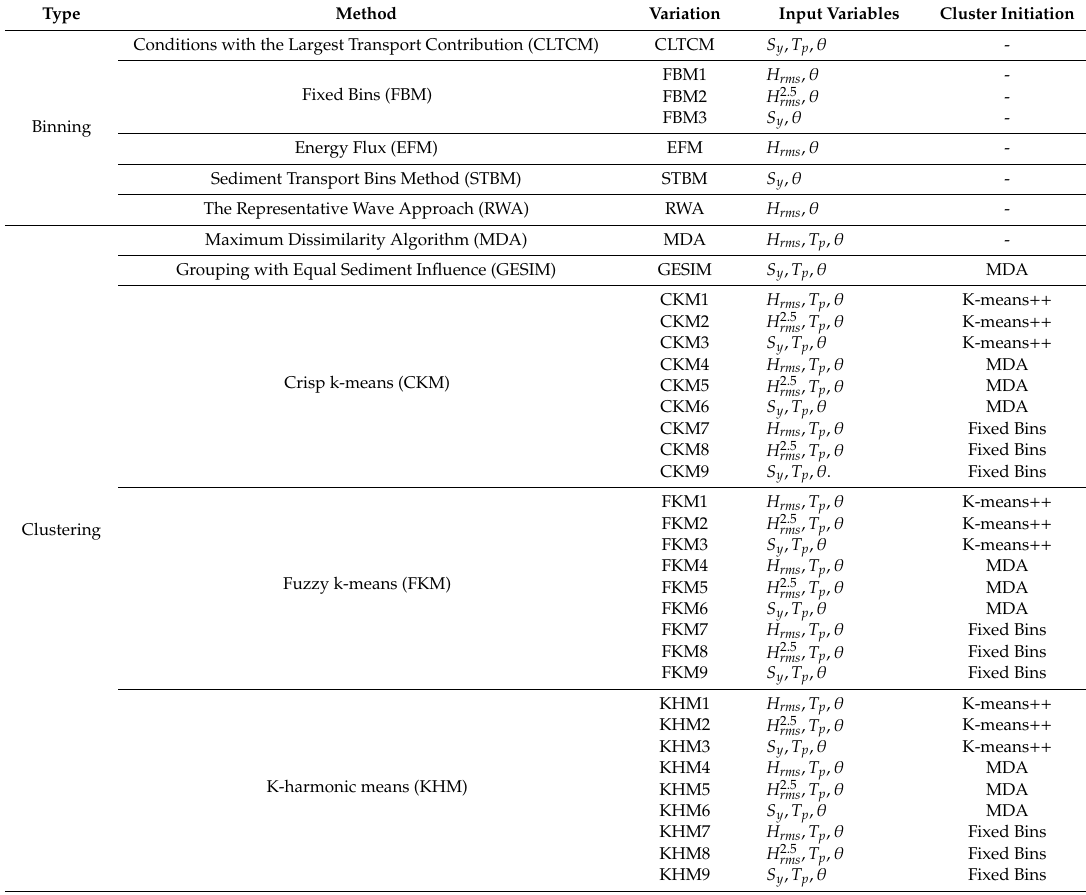
Table 1. Overview of simulated input reduction (IR)-methods and variations. The meaning of the variable symbols is as follows: S y = longshore sediment transport; T p = wave peak period; θ = wave angle; H rms = root-mean-square wave